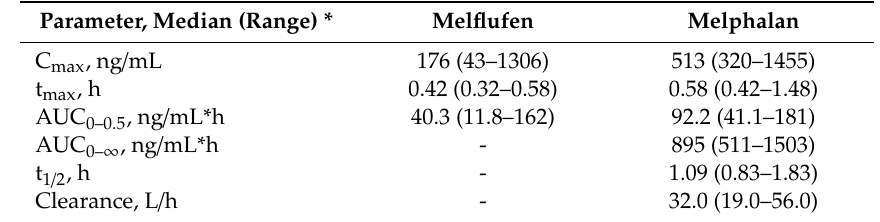
Table 2. Pharmacokinetics of melflufen and melphalan following administration with 50 mg melflufen